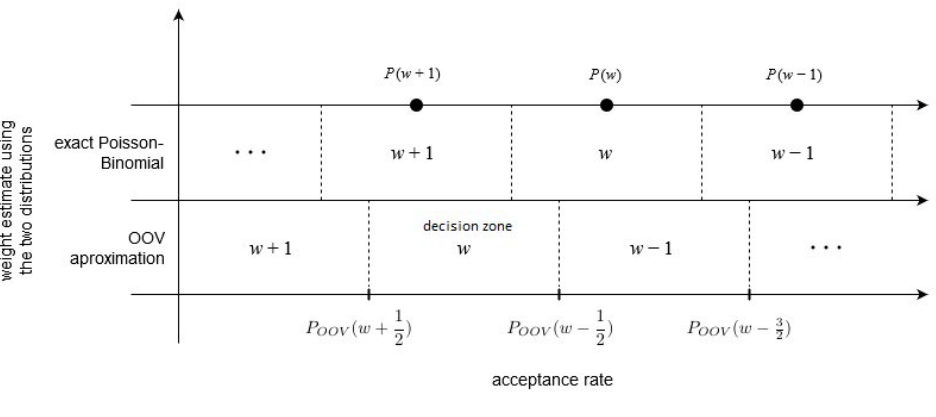
Figure 10. Different “decision zones” according to the OOV approximation and the exact Poisson- Binomial